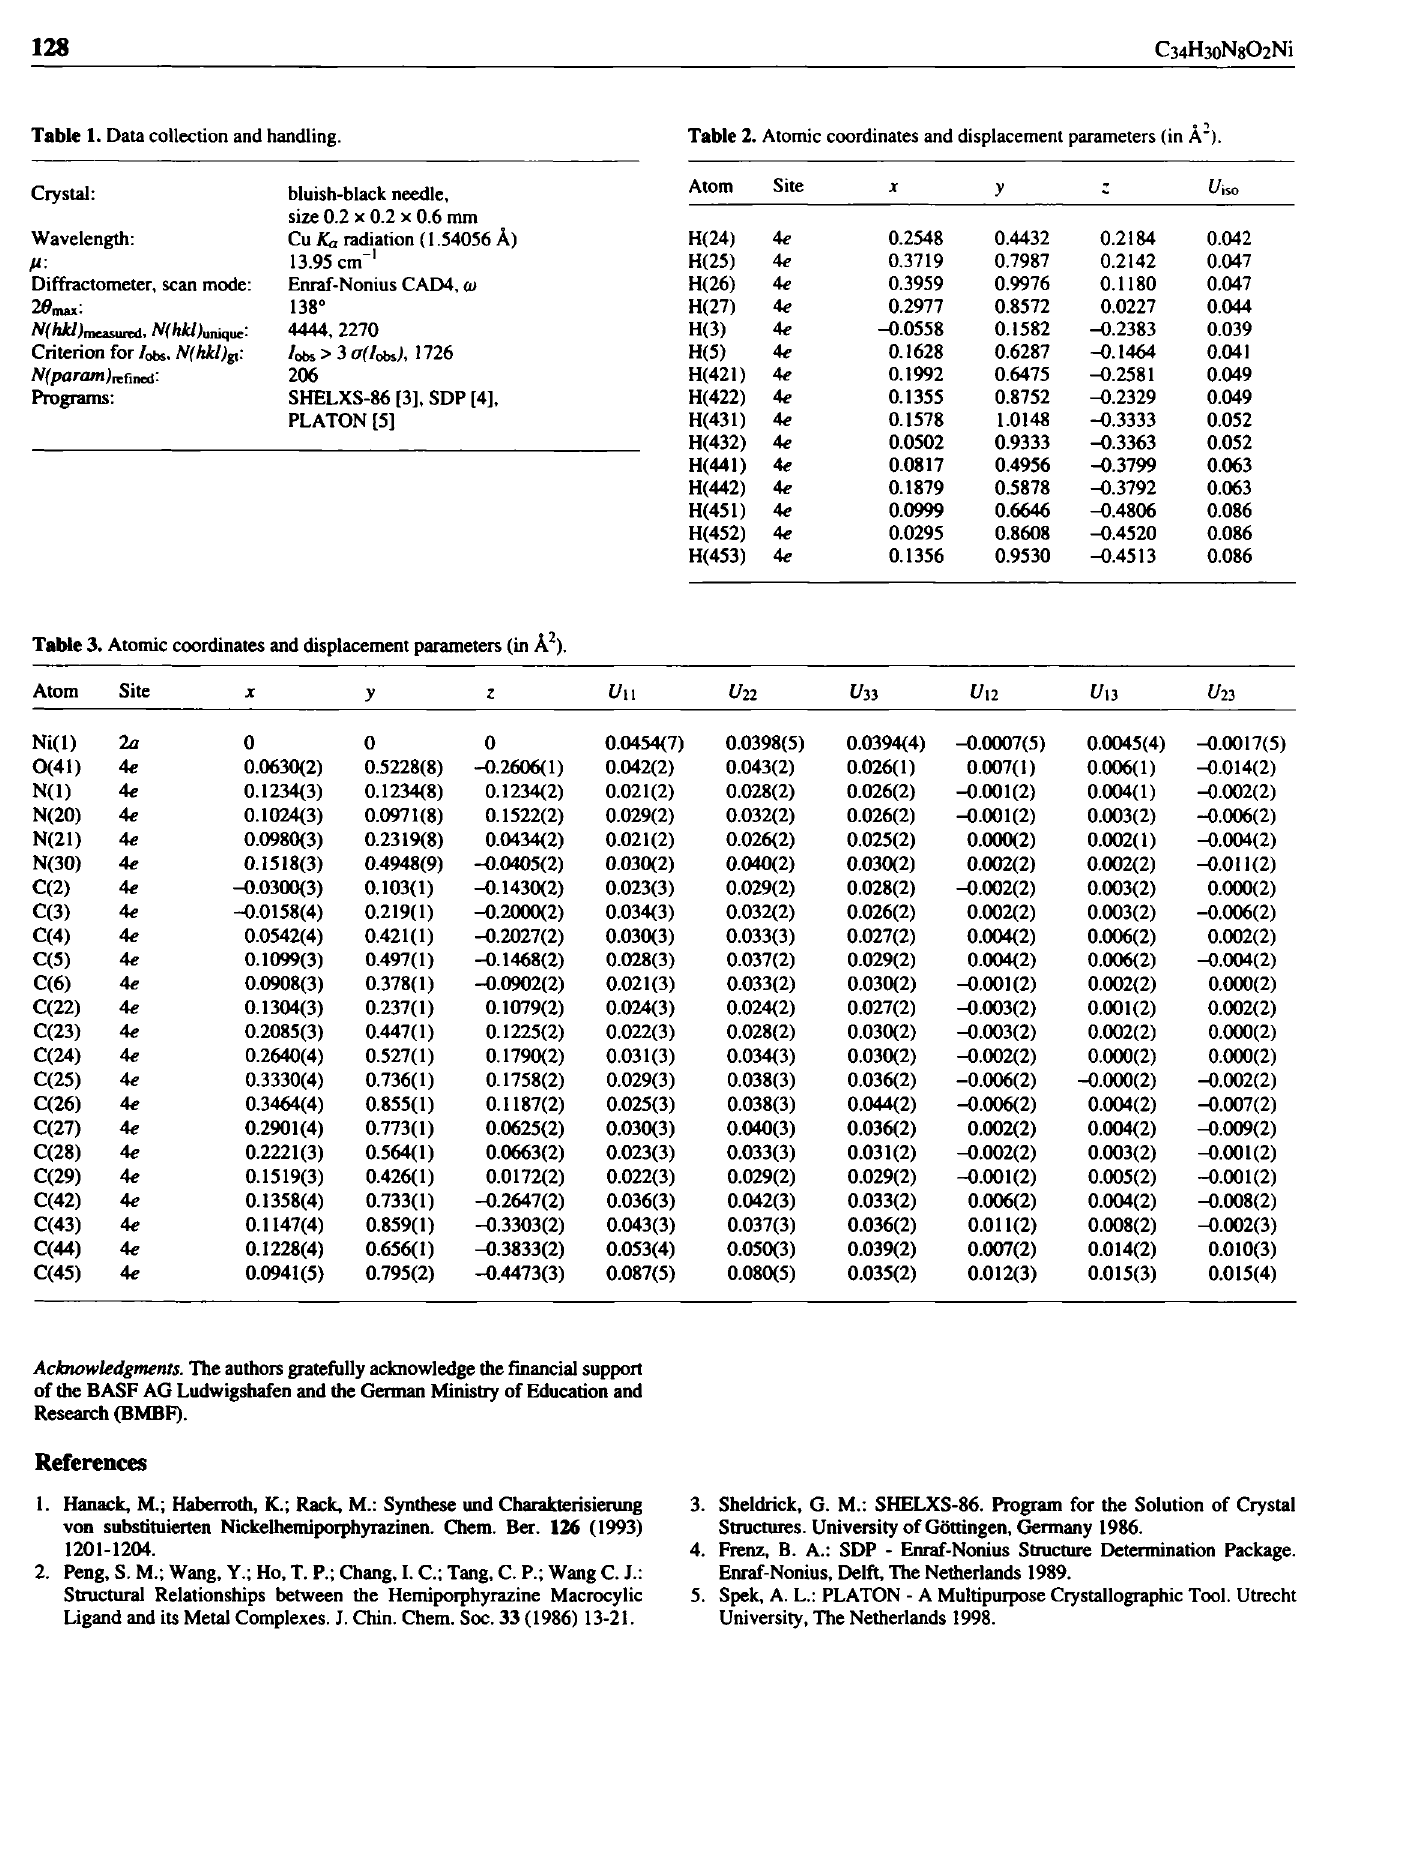
Table 1. Data collection and handling. Table 2. Atomic coordinates and displacement parameters (in Â").